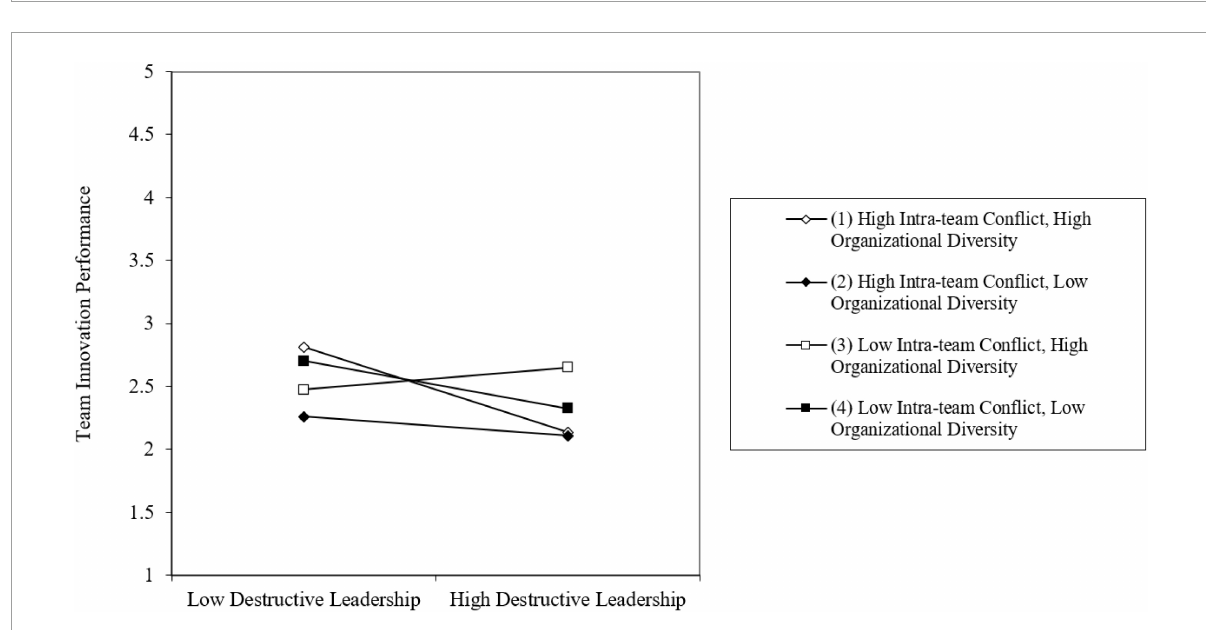
FIGURE3 Three-way interaction effect of destructive leadership, intra-team conflict, and organizational diversity on team innovation performance.